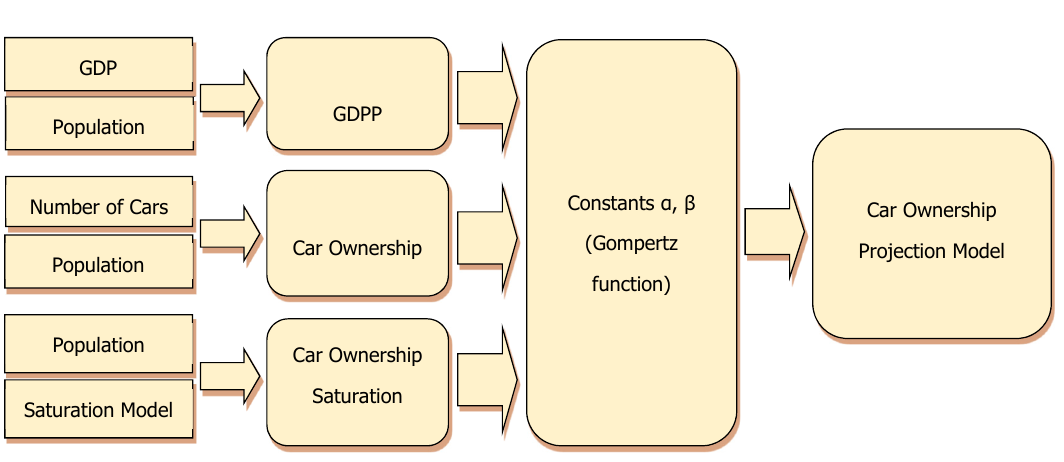
Figure 3. Scheme of the car ownership projection model.